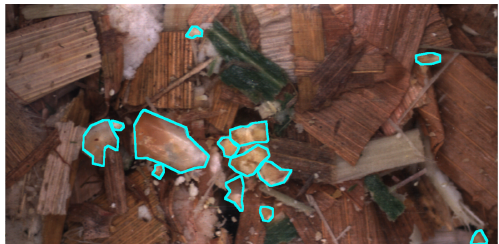
Figure 4. An example of how to annotate fragments that are grouped closely together.